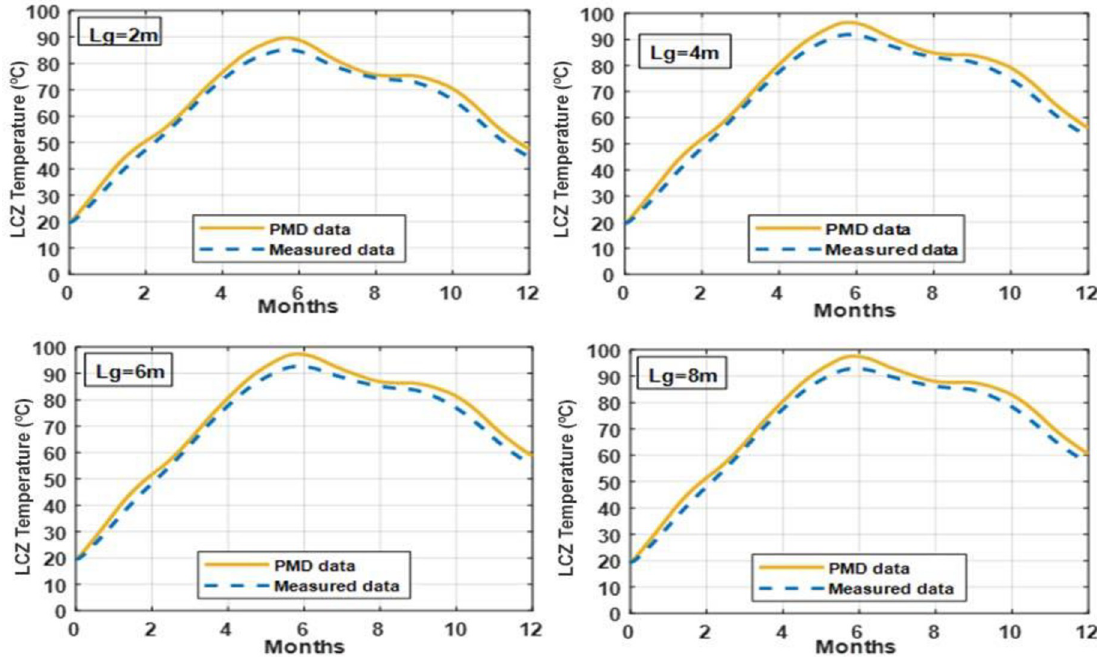
Fig 9. LCZ temperature with different depths of water table under the solar pond for whole year simulation under PMD and measured climatic conditions of Lahore.